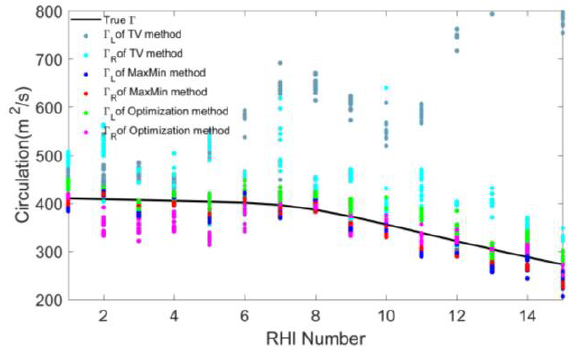
Fig. 4 Circulation Result on 15 Simulated